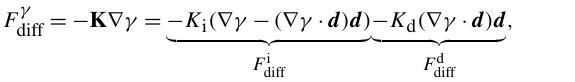
(cid:16) (cid:17) F i and diff